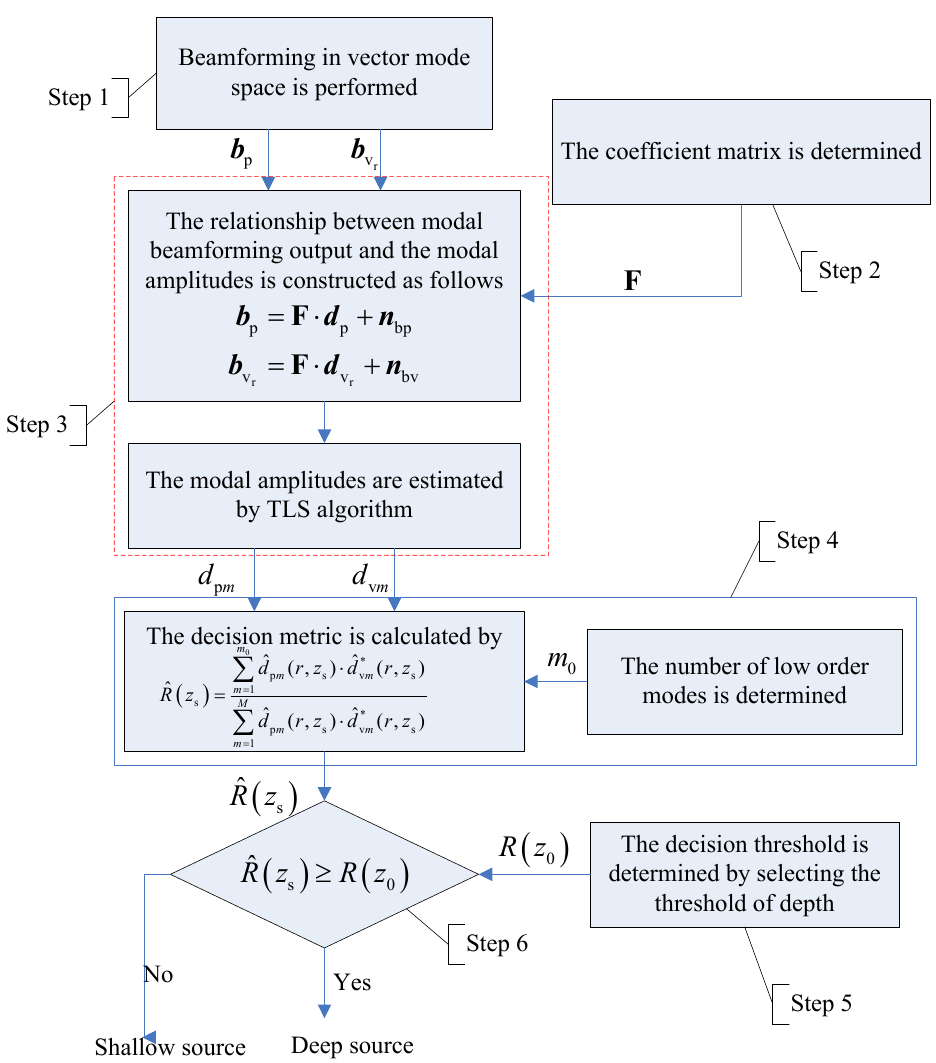
Figure 5. Diagram of source depth discrimination based on mode extraction.